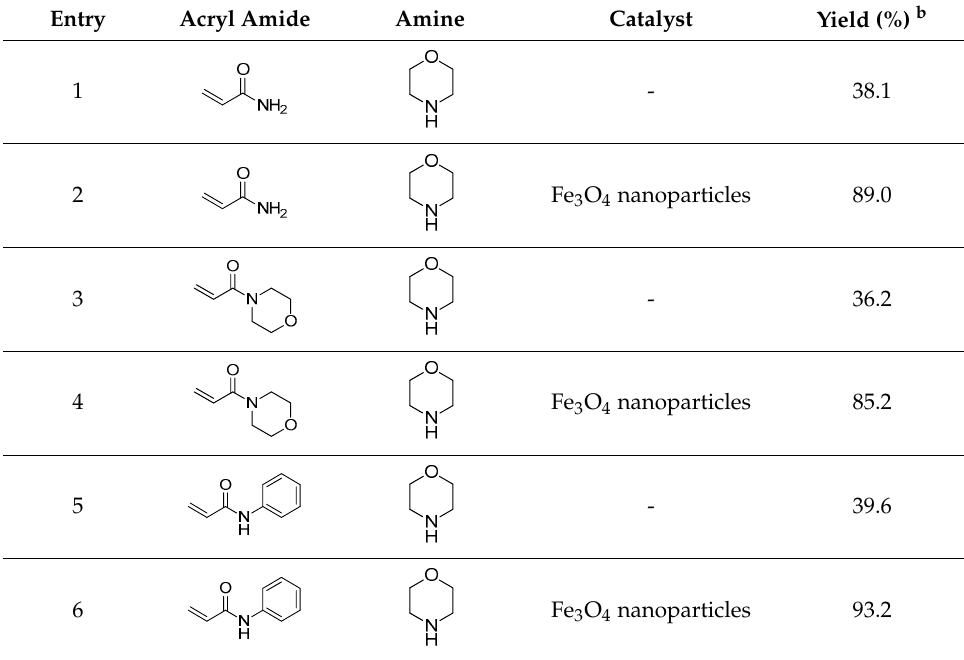
Table 1. Influence of the Fe 3 O 4 nanoparticles on the aza ‐ Michael addition of various substituent on N position of acryl amides with morpholine. a